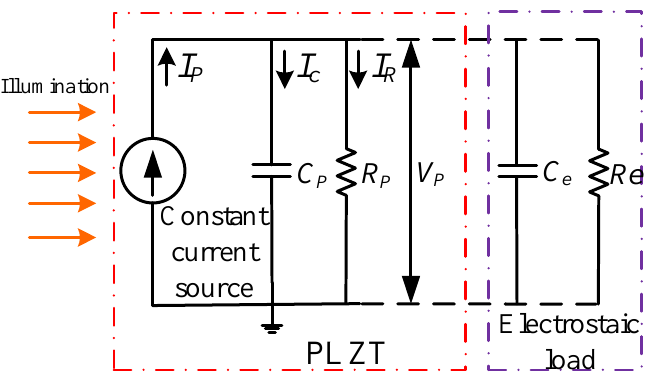
Figure 1. Equivalent electrical model for photovoltaic/electrostatic hybrid driving.